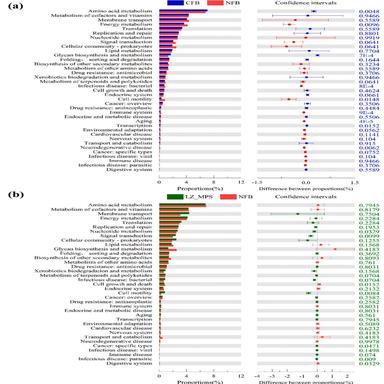
Functional prediction of gut microbiota based on KEGG pathways at level II. NFB, without carbon source group; CFB, inulin treatment group; LZ_MPS, LZ-MPS treatment group; MC_MPS, MC-MPS treatment group; G_MPS, G-MPS treatment group. Differences were considered significant at P < 0.05.